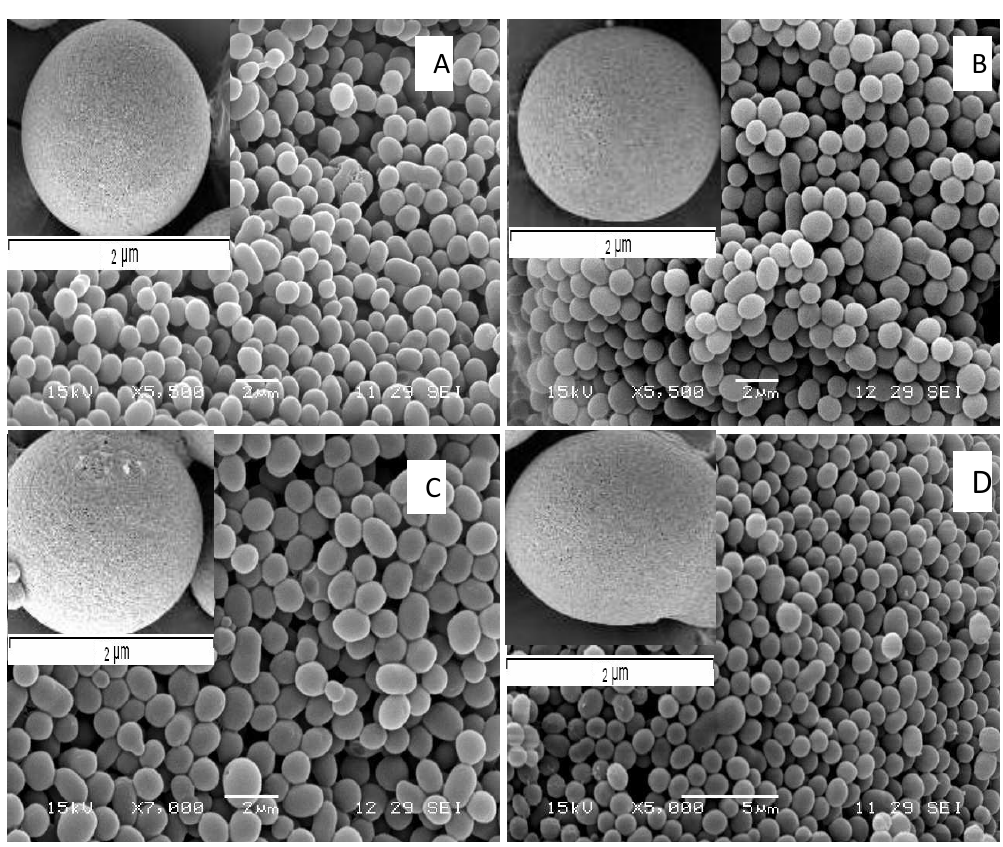
Figure 4. (SEM) of P(3HB) microspheres prepared under different conditions described